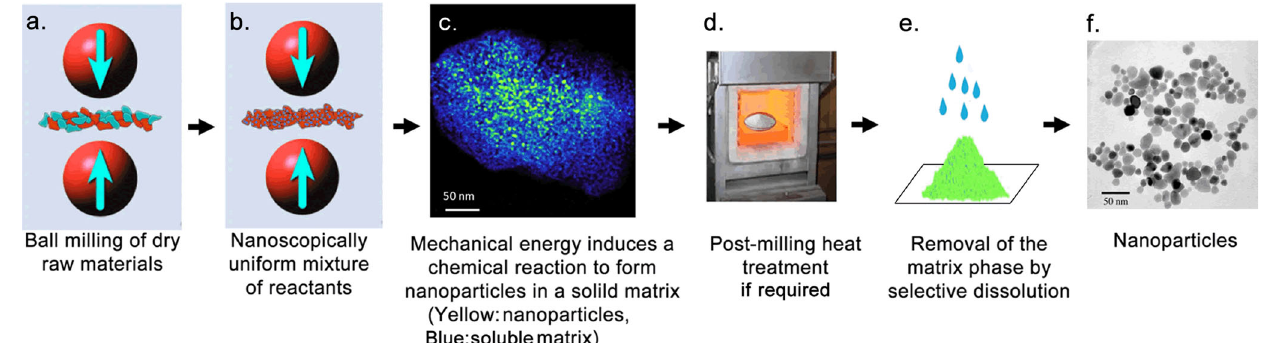
Fig. 1 Typical steps of mechanochemical processing to produce nanoparticles via a solid-state displacement reaction. a Dry raw reactant materials are placed in a milling container along with milling balls. b During ball milling, repeated fracture and welding of the raw materials result in the formation of a nanocomposite of the reactants. c Mechanical energy input into the reactant nanocomposite induces a chemical reaction to produce nanoparticles in a solid matrix 48 (reproduced with permission from Springer). d If necessary, post-milling heat treatment is conducted to complete the chemical reaction or to control the size, shape or crystallinity of nanoparticles. e Soluble by-product matrix phase is removed. f Final